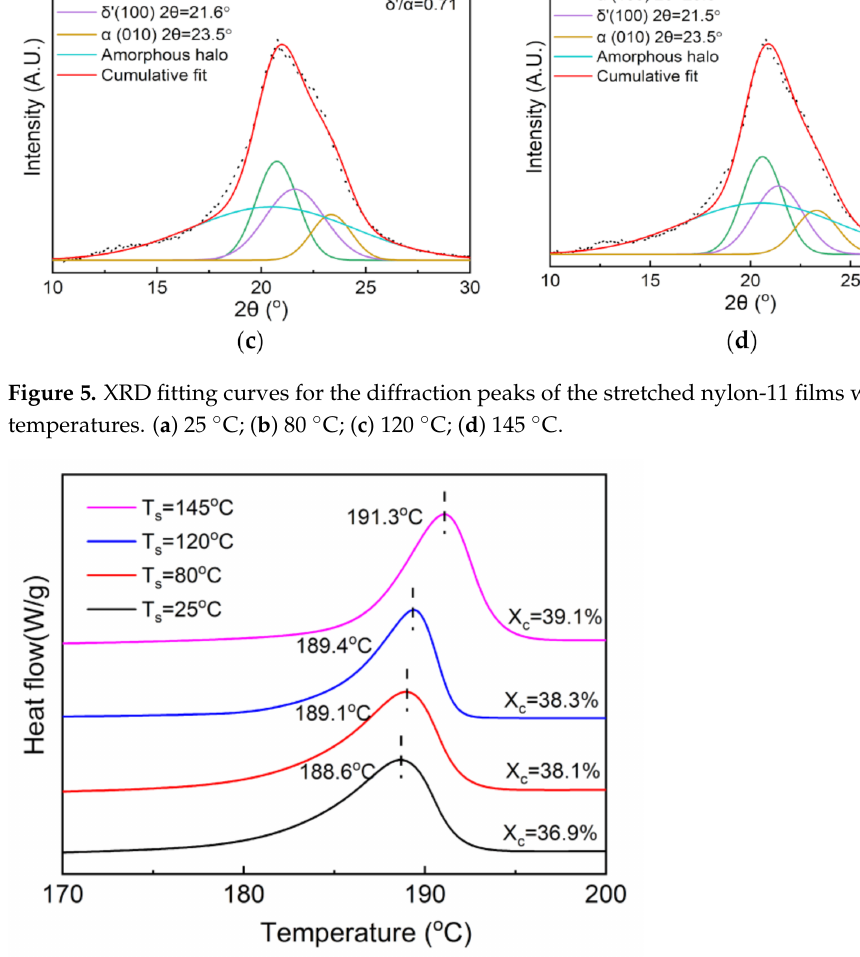
Figure 6. DSC melting curves of the stretched nylon-11 films with different stretching temperatures (T s ). The stretching ratio is set as